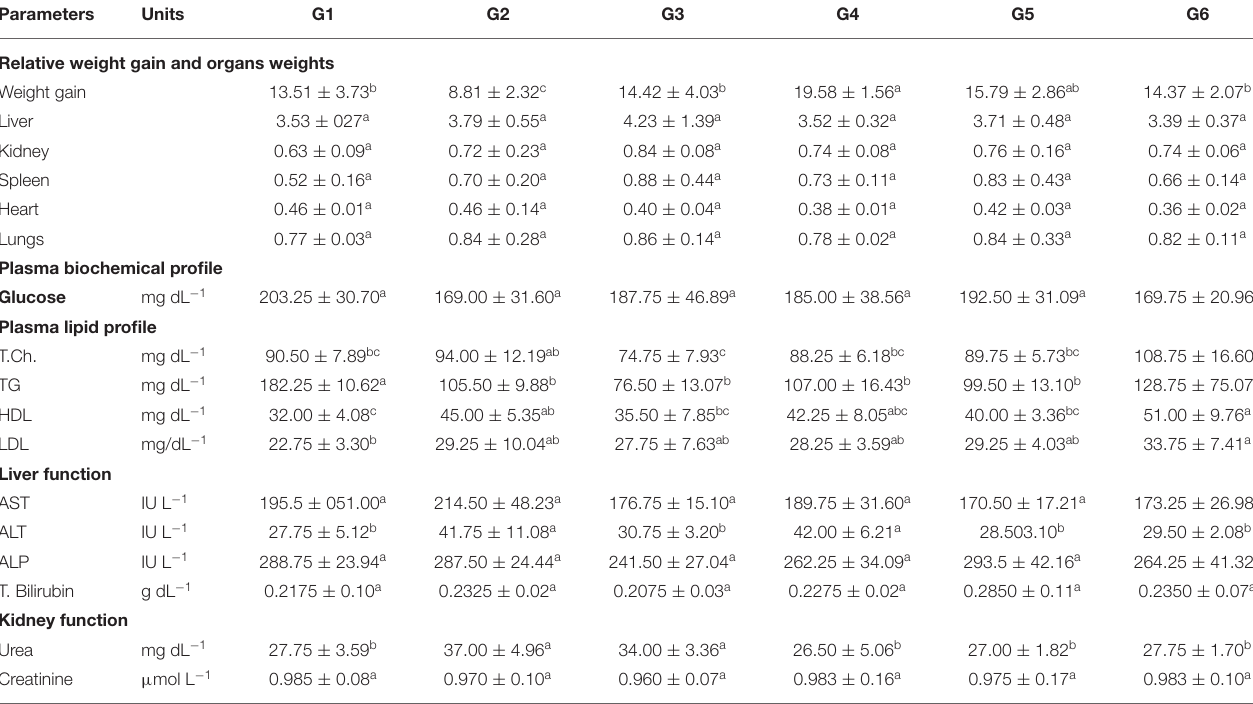
TABLE 5 | Fortified SFY impact on relative organs weights and plasma biochemical profile of treated rats.